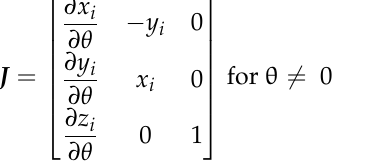
. . P = J q ) is expressed in Equation (17) when θ (cid:54) = 0: c i